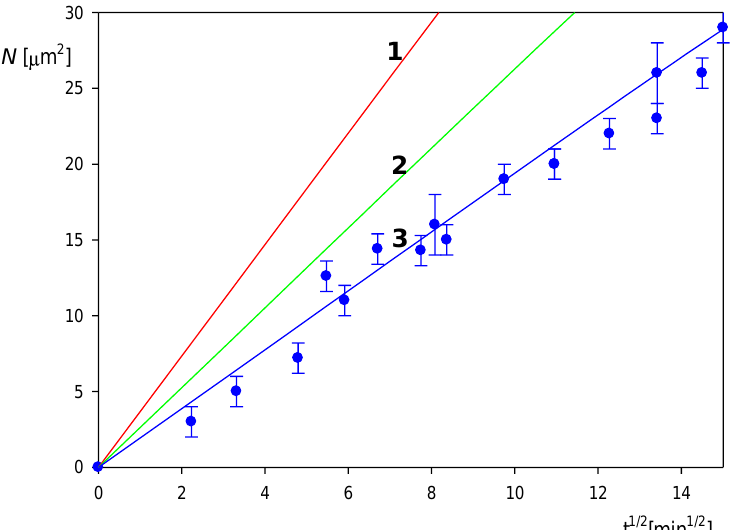
Figure 4. Kinetics of the polystyrene particle deposition on PLL functionalized mica under diffusion conditions shown as the dependence of surface concentration N [ µ m − 2 ] on the square root of the deposition time t 1/2 [min 1/2 ]. The points denote experimental results obtained by a direct AFM enumeration for c p = 100 mg L − 1 , pH 3.5 and 10 mM NaCl. The solid lines show the theoretical results derived from Equation (3) for the particle diameter equal to the following: 1. 100 nm, 2. 110 nm, 3. 120 nm.